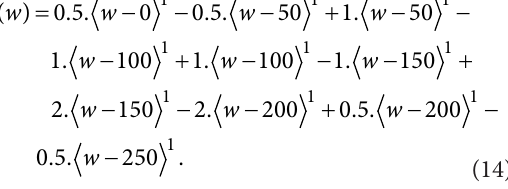
Figure 7. Typical time-cost-trade-off Pareto front obtained using proposed